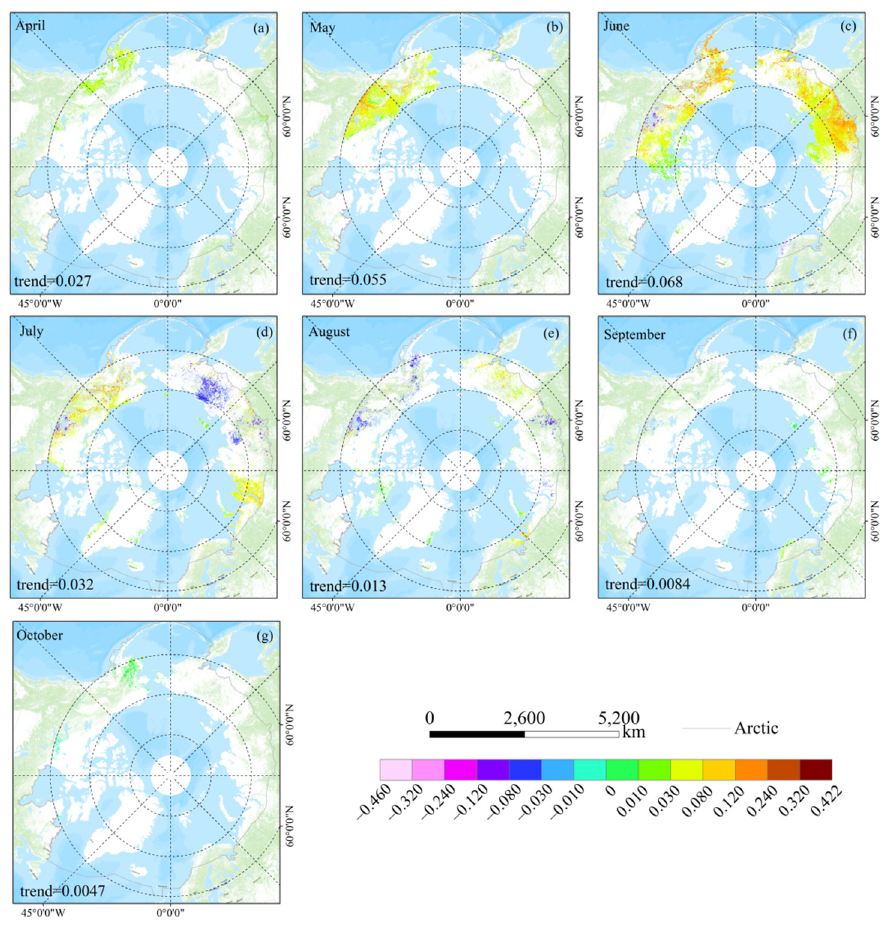
Figure 15. Spatial distribution of the interannual variation trend (g C m − 2 year − 1 ) of monthly GPP over the Arctic, ( a – g ) refers to April to October.